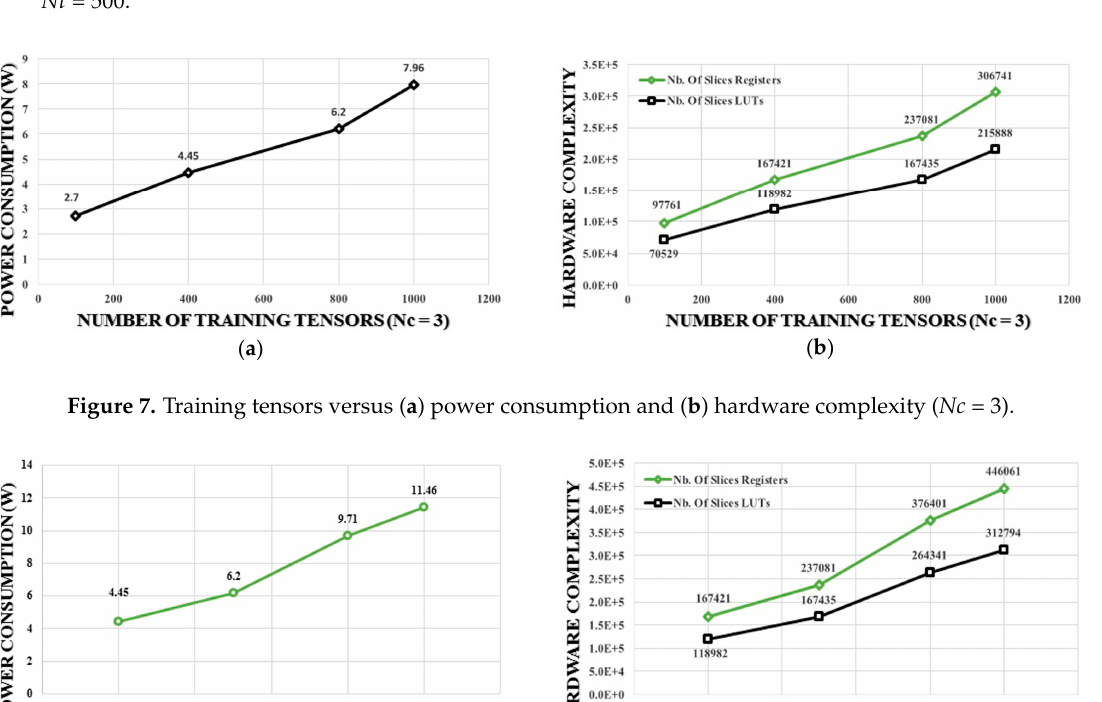
Figure 6. Parallel architecture for the tensorial approach hardware implementation for Nc = 5 and Nt = 500.